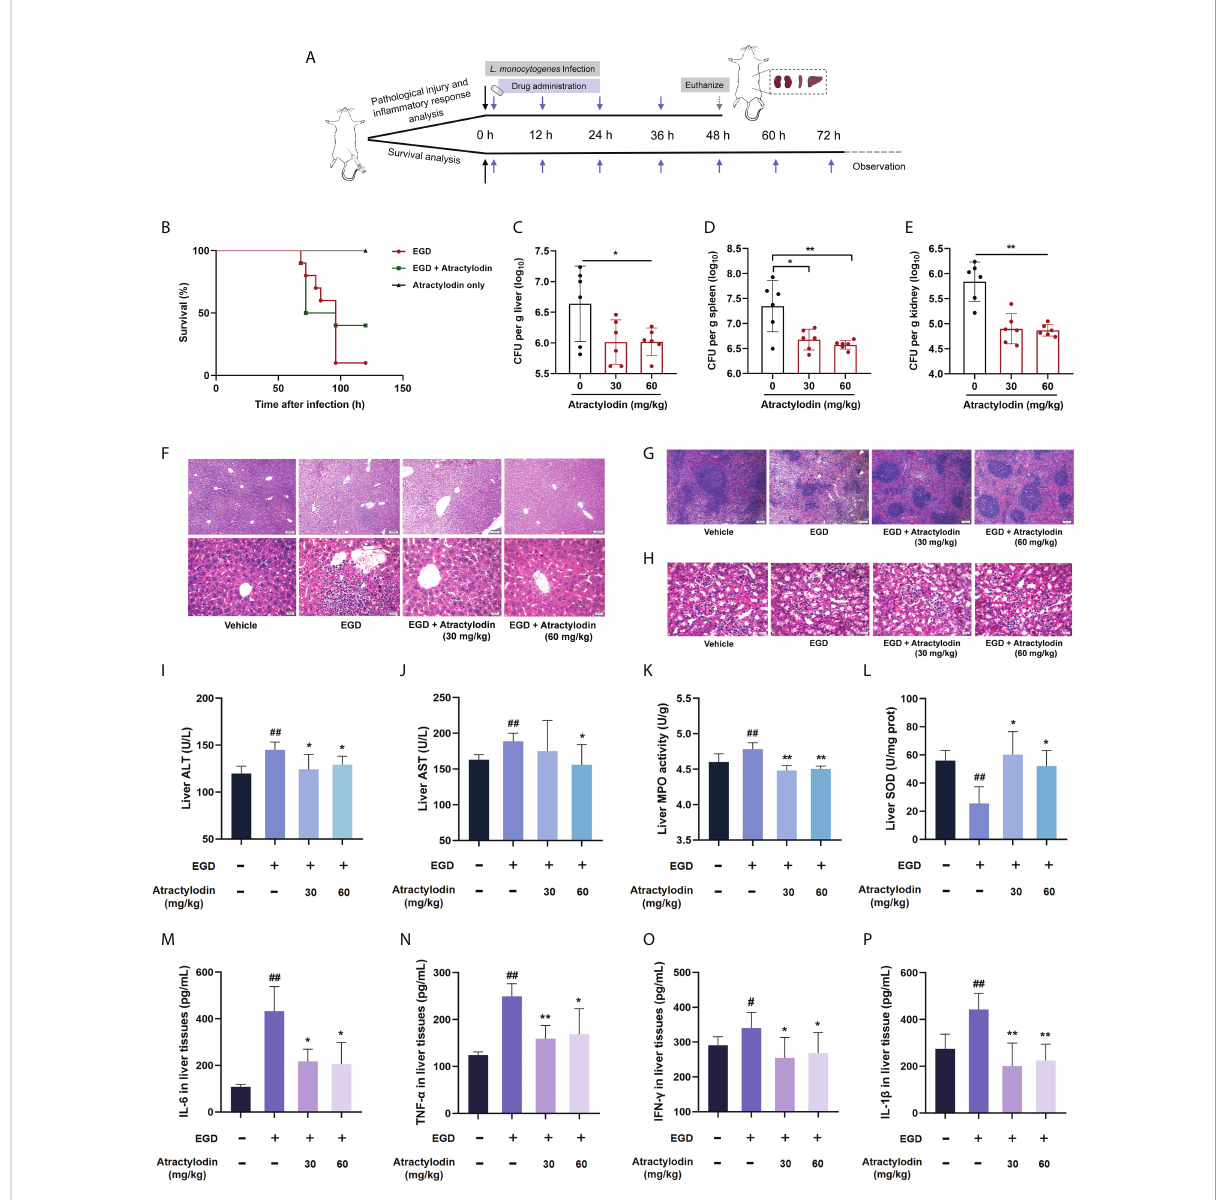
FIGURE 4 Atractylodin treatment protected mice from L. monocytogenes infection. (A) Scheme of the experimental protocols for L. monocytogenes systemic infection model. Mice were infected with L. monocytogenes EGD intraperitoneally and received a hypodermic injection of atractylodin (30 or 60 mg/kg/day) at 12-h intervals. (B) Survival analysis of mice treated with solvent control or 60 mg/kg/day atractylodin (n = 10 per group). The bacterial burden in the livers (C) , spleens (D) and kidneys (E) were determined at 48 h post-infection in the control group and the atractylodin-treated groups (n=6 per group). Histopathological observations of livers (F) , spleens (G) and kidneys (H) by H&E staining. The typical lesions in L. monocytogenes EGD infected mice were marked with white triangle. (I – L) Effects of atractylodin on levels of ALT, AST, MPO and SOD from liver homogenates of EGD-infection mice. Cytokines levels of IL-6 (M) , TNF- a (N) , IFN- g (O) and IL-1 b (P) in liver homogenates were assessed using ELISA. The data are presented as the mean ± SEM. # P < 0.05 and ## P < 0.01 vs the vehicle control group; * P < 0.05 and ** P < 0.01 vs EGD-infection